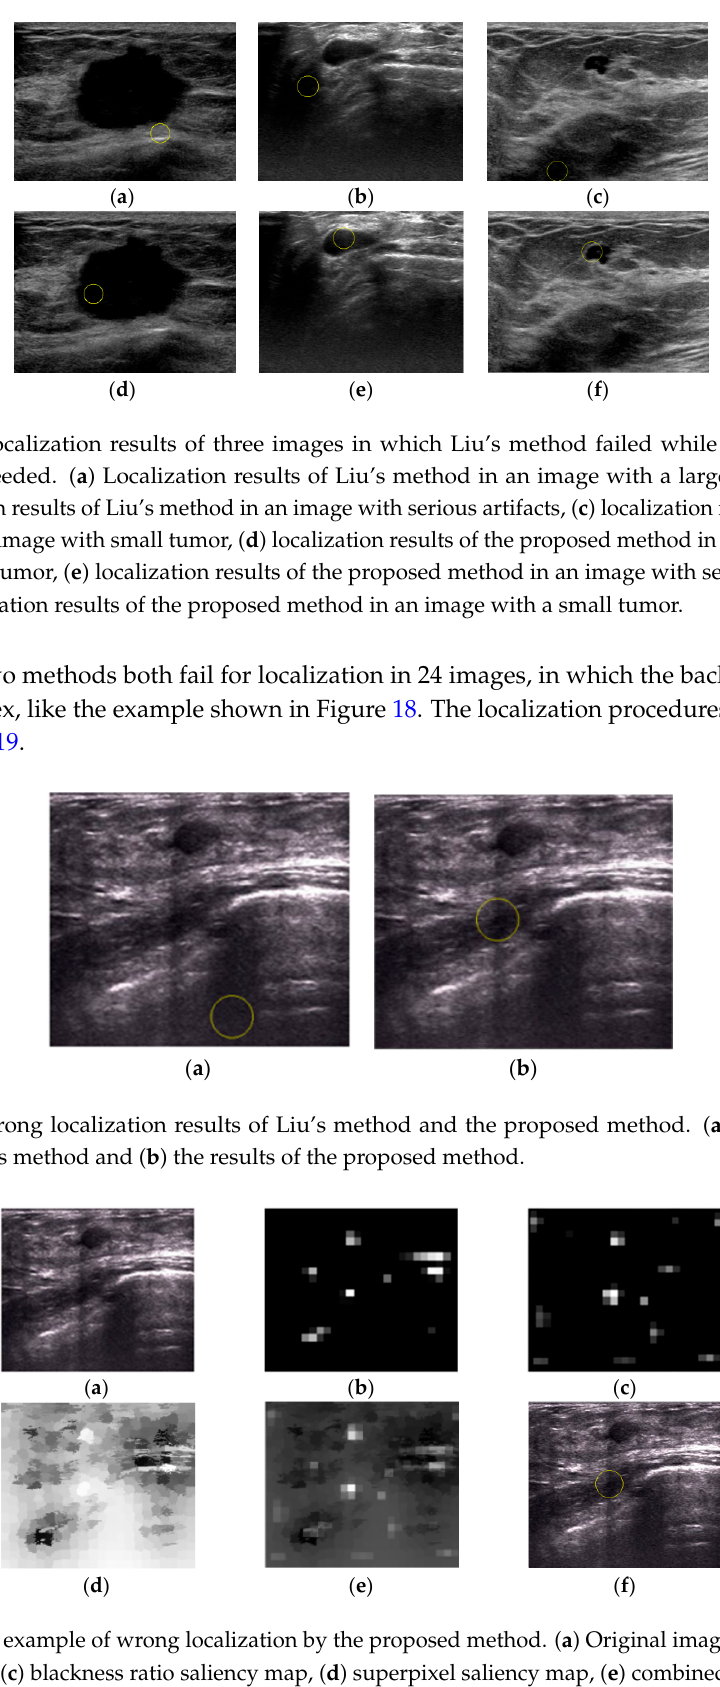
Figure 19. An example of wrong localization by the proposed method. ( a ) Original image, ( b ) intensity saliency map, ( c ) blackness ratio saliency map, ( d ) superpixel saliency map, ( e ) combined saliency map of three features, and ( f ) localization